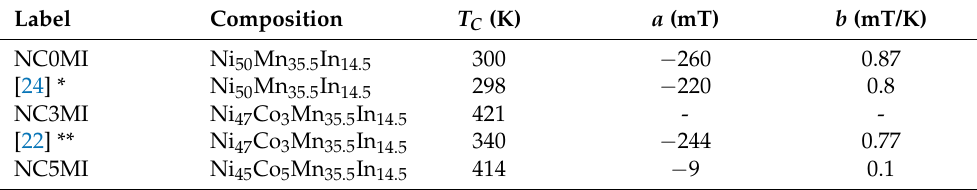
Table 2. The corresponding EMR results of NC0MI, NC3MI, and NC5MI samples and comparison with literature data. T C are determined from the temperature dependence of integral intensity, a and b parameters are determined from temperature dependence of the EMR